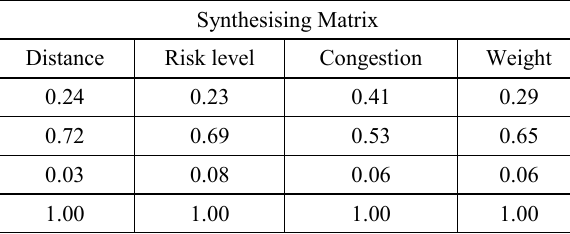
Table 2. Synthesising matrix